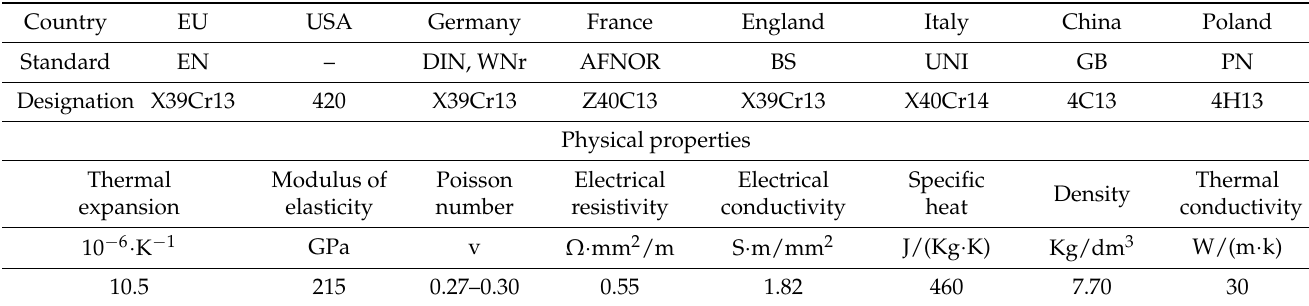
Figure 3. Overall view of the planar cutting blade used in experiments ( a ) and outline drawings of the cross-sectional geometry of the blades tested: ( b ) blade geometry 1; ( c ) blade geometry 2; ( d ) blade geometry 3; ( e ) blade geometry 4. Table 2. The physical properties of X39Cr13 high-carbon martensitic stainless